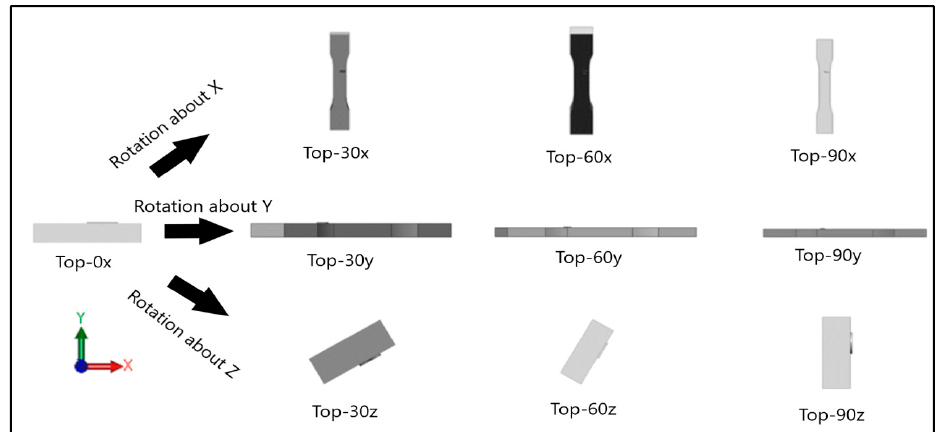
Figure 5. Front view of top-built samples, 0°, 30°, 60°, and 90° from left to right for each axis rotation (separate rows for x, y, and z-axis), respectively.